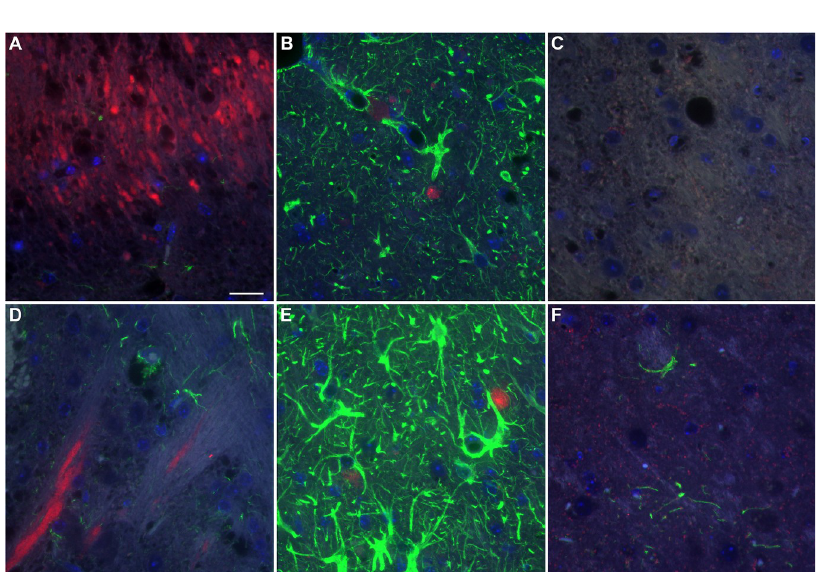
Fig 7. PrP-3F4 does not colocalize with astrocytes following IC inoculation of Tg3F4 mice with ME7 prions or NBH. PrP-3F4 (red) and GFAP (green) in the hypothalamus of NBH (A and B) or thalamus of ME7 (D and E) inoculated mice 24 hrs (A and D) and 2 weeks (B and E) post inoculation. (C) No primary control. (F) Thalamus of unninoculated Tg3F4 mouse. PrP-3F4 was detected using a biotinylated form of the anti-PrP mouse monoclonal antibody 3F4. DAPI stain for nuclei = blue; Scale bar = 20 μ